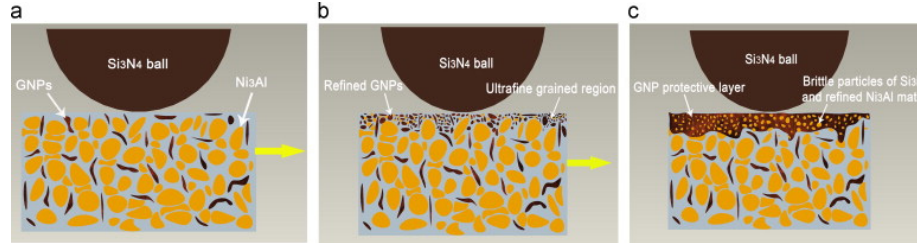
Figure 17. The schematic of the wear mechanism of NMSC − GNP. Reproduced with permission from [125]. Copyright Elsevier, 2014.